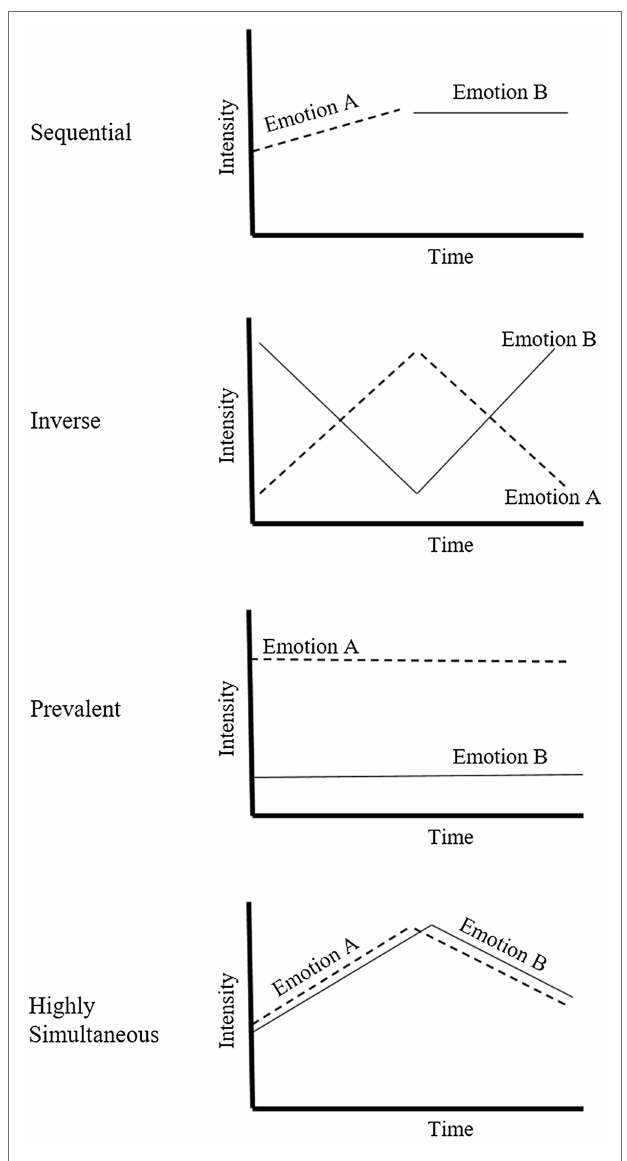
FIGURE 1 | Schematic representation of the analogue emotions scale (AES) patterns as described by Oceja and Carrera